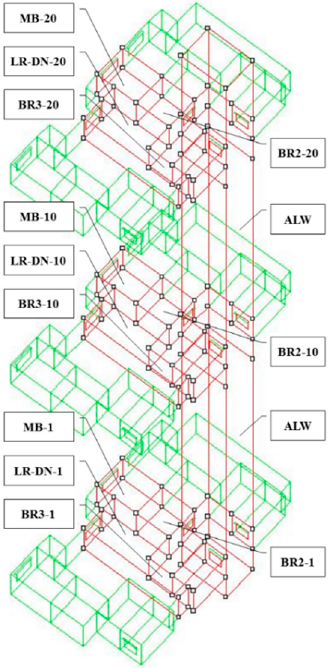
Figure 15. The second simulation model in Integrated Environmental Solutions (IES).